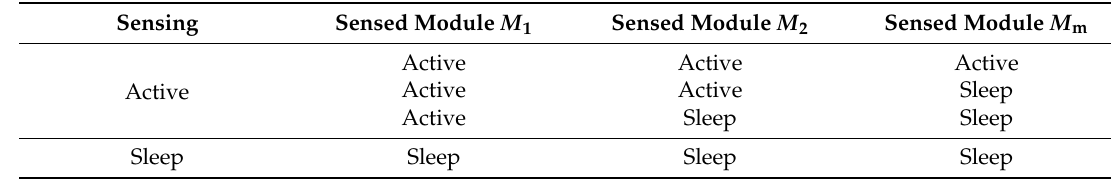
Table 2. Sleep states of multi-mode sensed modules.